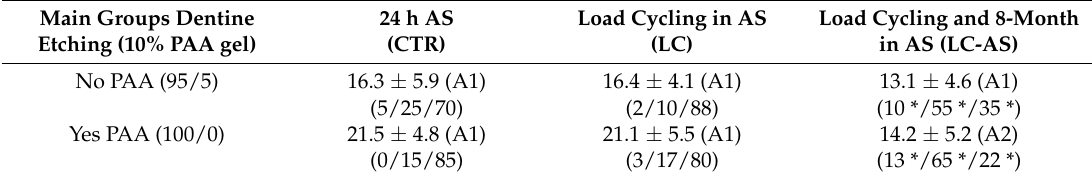
Table 1. The results show the mean ± SD of the MTBS (MPa) to dentine when resin-modified glass ionomer cement was applied after different dentine